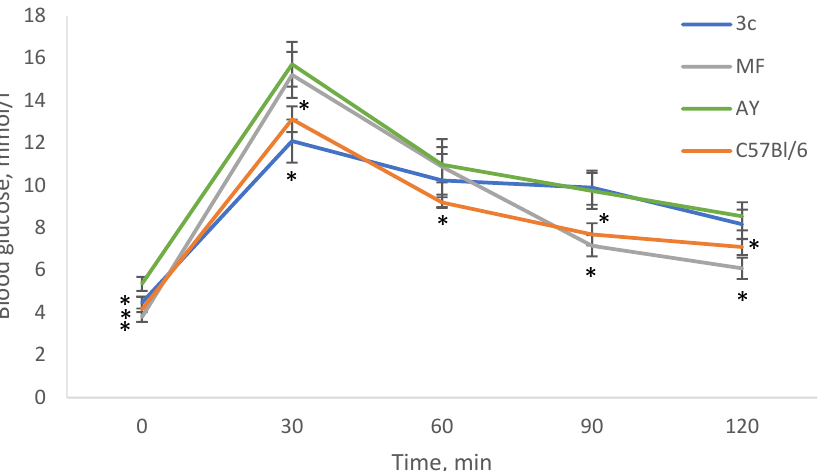
Figure 4. The results of the OGTT performed after 4 weeks of AY mice treatment by compound 3c at a dose of 15 mg/kg. MF was introduced at a dose of 250 mg/kg. * p < 0.05 as compared to AY mice. When evaluating the area under the glycemic curve, the effects of compound 3c and MF were the same (Figure 5).